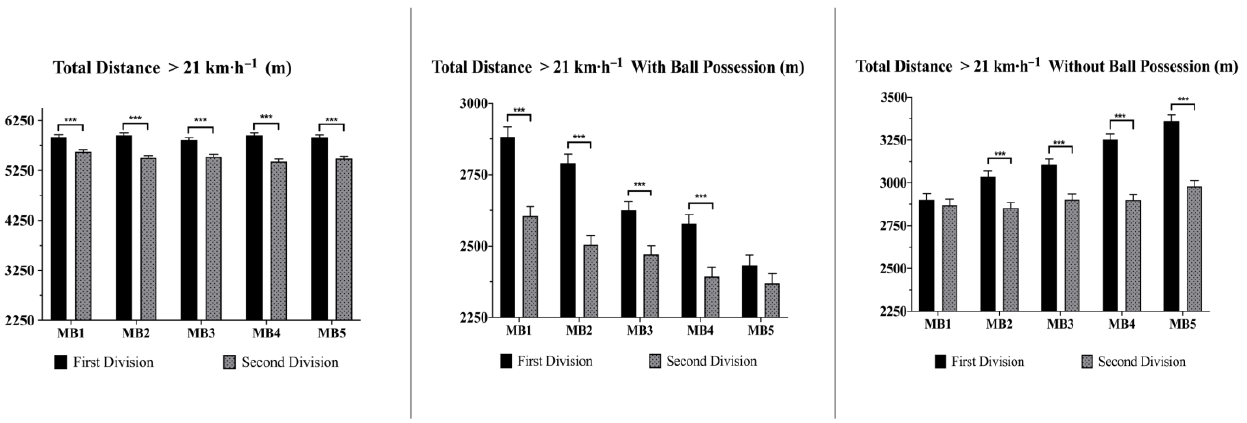
Figure 2. The total distance covered at < 21 km∙h −1 (in meters) with and without ball possession. ** p < 0.01. *** p < 0.001.